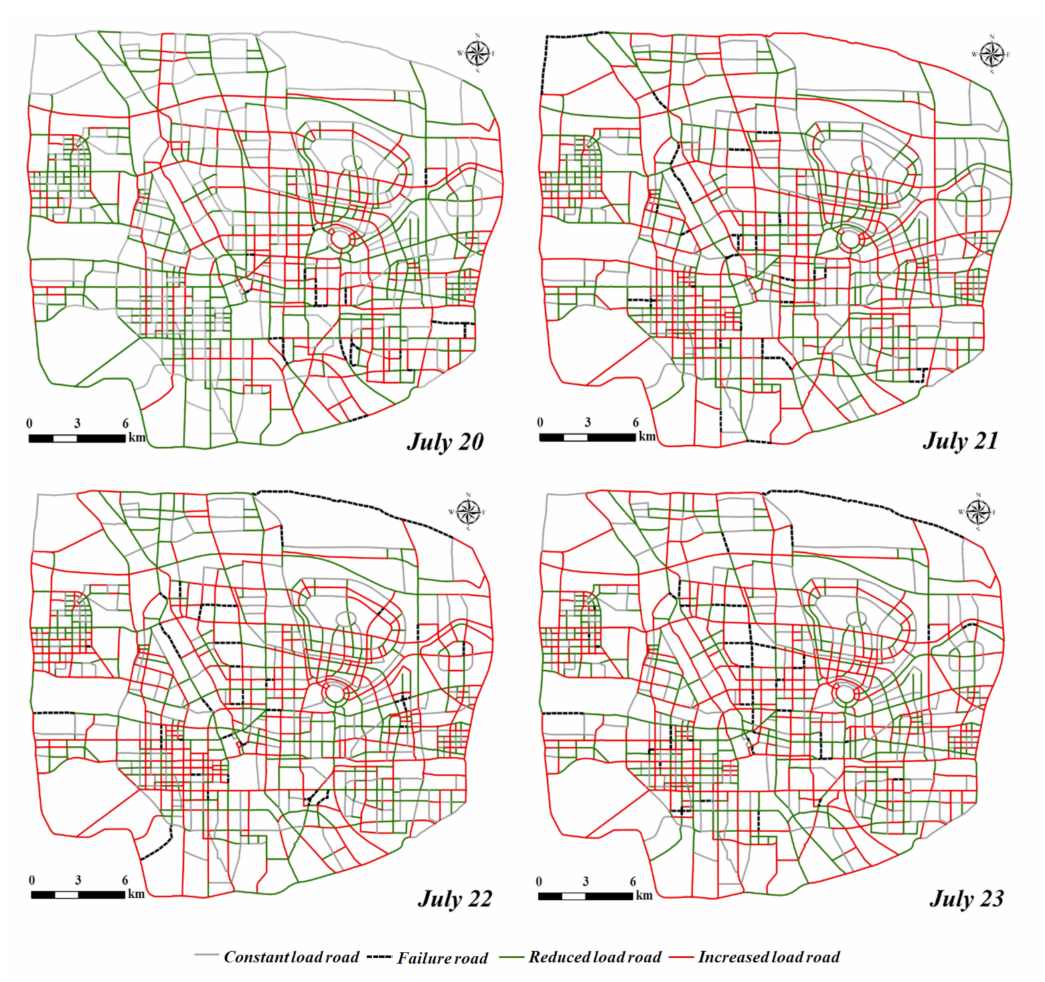
Figure 9. Spatiotemporal patterns of the road network cascade failure during the